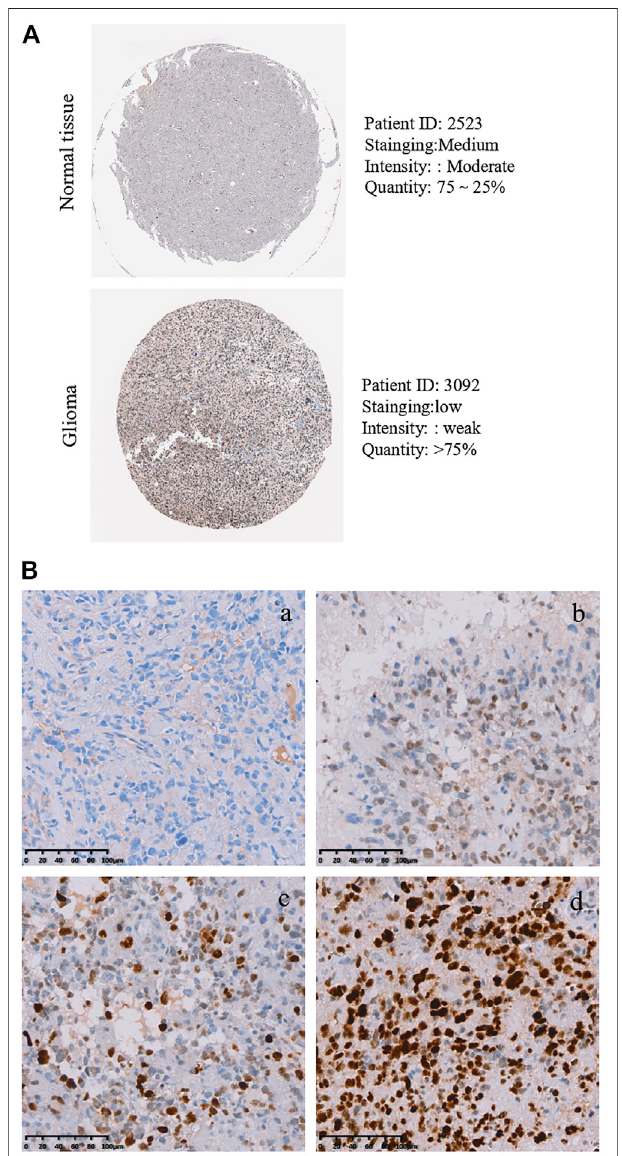
FIGURE 3 | Protein levels of PLAGL2 protein expression in HGG samples. (A) Valiation of PLAGL2 in HGG from HPA. (B) Representative immunohistochemistry images of negative (WHO III), low (WHO III), moderate (WHO IV) and high (WHO IV) PLAGL2 protein expression (original magni fi cation ×200).